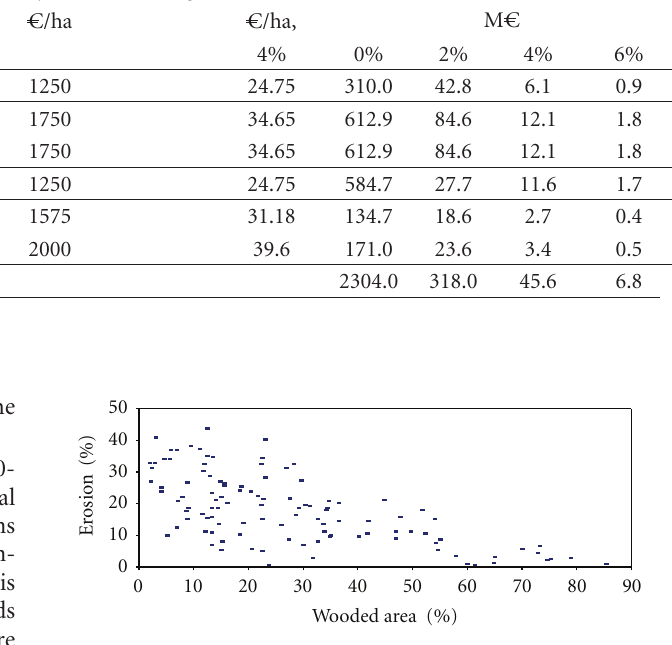
Figure 2: Relationship: wooded